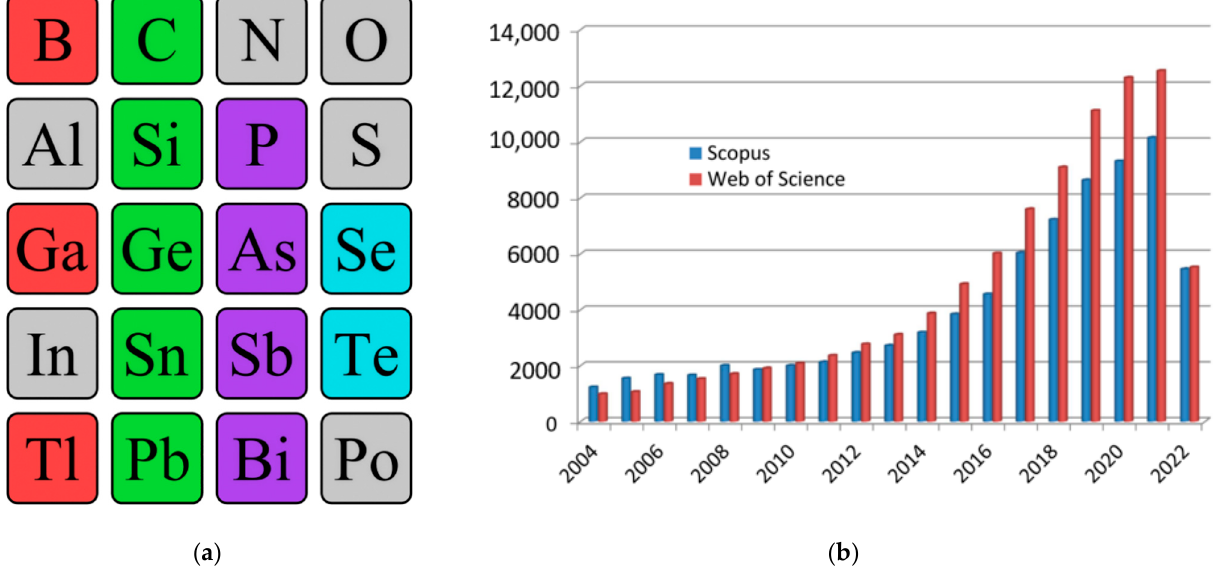
Figure 1. Single-element 2D materials ( a ) and number of publications with the keyword “2D material” in scientific analytical databases Scopus and Web of Science ( b ). In the excerption from the periodic table, synthesized single-element two-dimensional materials are highlighted: group IIIA—red, group IVA—green, group VA—violet, group VIA—blue.